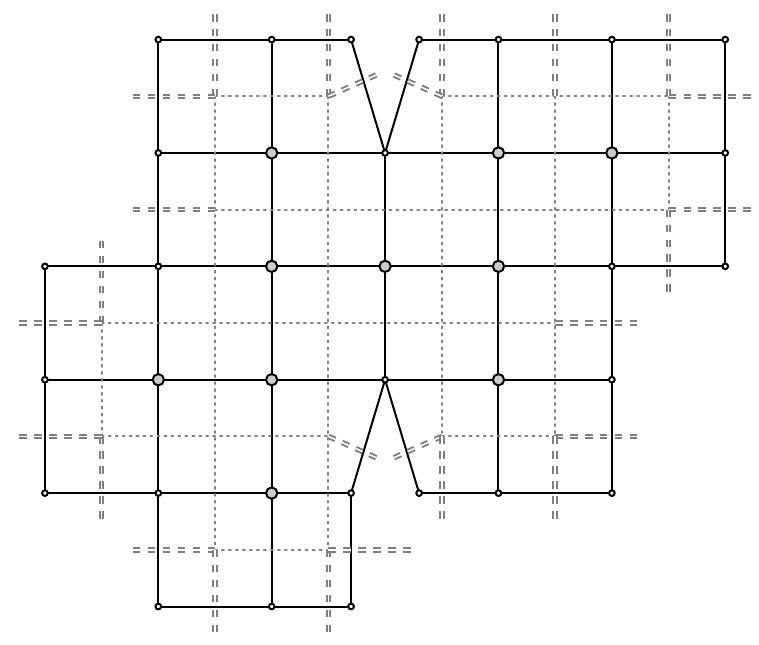
Figure 12 . A (cid:12)shnet correlator graph with a generic boundary is drawn by solid lines. Here several propagators meet in external points. Integration points are denoted by (cid:12)lled blobs. Propagators stretched between a pair of external vertices are inert with respect to loop integrations. The dual (momentum-space) graph is drawn by dotted lines. All incoming momenta are o(cid:11) shell and denoted by double lines. Figure 13 . The Lax operator from the monodromy acting onto the junction of: (A) one, (B) two, (C) three, (D) four, (E) (cid:12)ve external legs. Rotating this picture by inhomogeneities (cid:14) (cid:14) ! (cid:6)